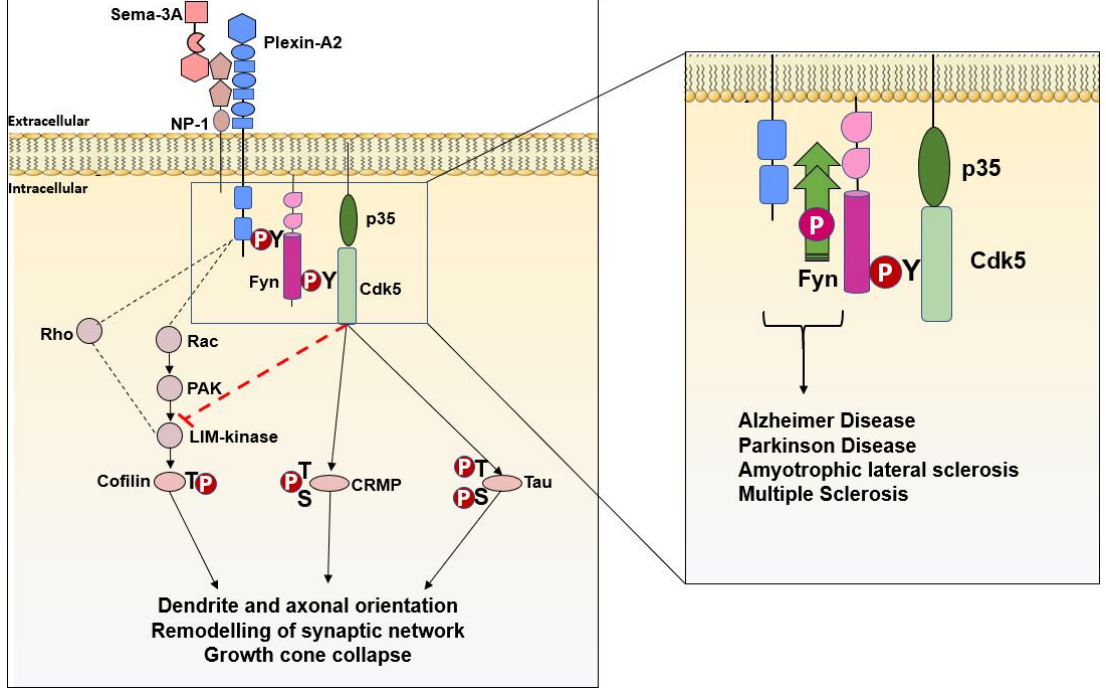
Figure 4. A proposed mechanism by which Fyn and Cdk5 control Sema3A and PlexinA2 downstream signaling cascade either in physiologic (left) or in pathologic (right) conditions. Fyn phosphorylates PlexinA2 and promotes PlexinA2 interaction to Sema3A. Fyn also phosphorylates cyclin-dependent kinase-5 (Cdk5) and in turn collapse response mediator protein (CRMP). The activation of Cdk5 facilitates the suppression of Rac-PAK signaling leading to the actin dynamic regulation. On the other hand, when phosphorylated, Cdk5 activates Tau resulting in destabilization of microtubules. Both these events culminate in growth cone collapse, remodeling of synaptic network and regulation of dendrites and axonal orientation (Adapted from Sasaki et al. 2002) [111] .